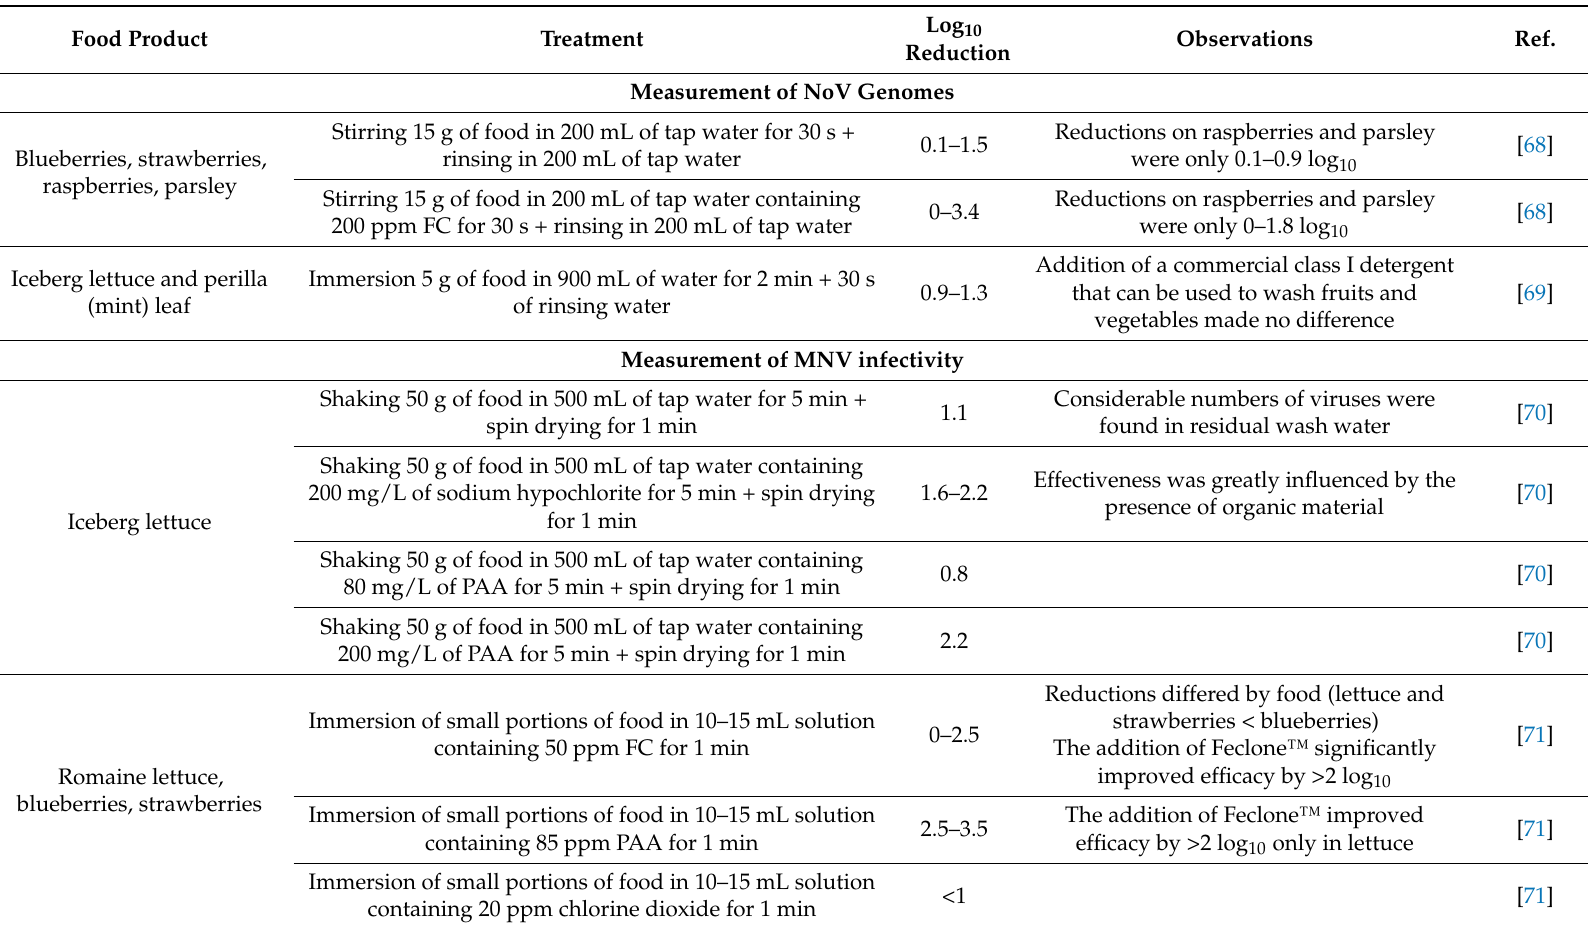
Table 3. Reductions of norovirus (NoV) and murine noroviurs (MNV) surrogate on food products by washing procedures that could be performed and/or transferred to private households provided that sanitizers were commercially available for